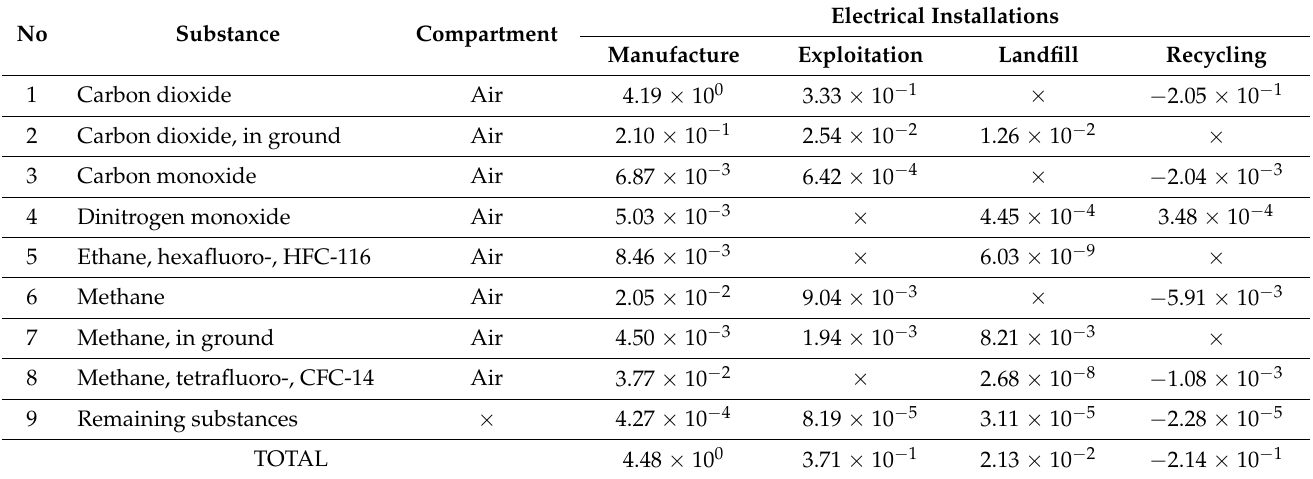
Table 14. The results of grouping and weighing the environmental consequences of emissions of compounds causing climate change due to electrical installations occurring at individual stages of the life cycle of the research object.